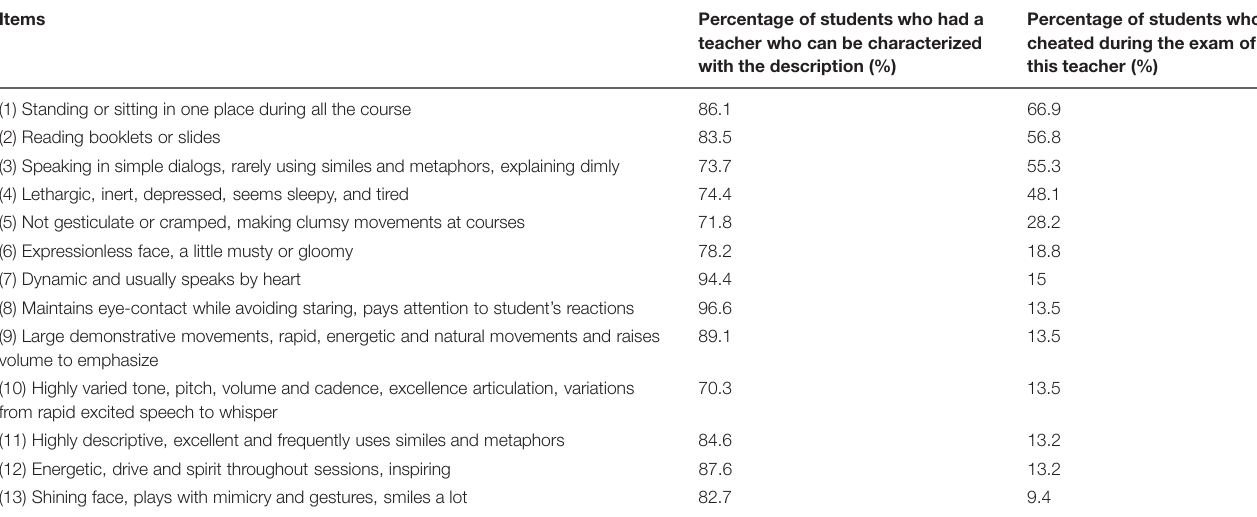
TABLE 1 | Descriptive data concerning the teacher enthusiasm and self-reported cheating of